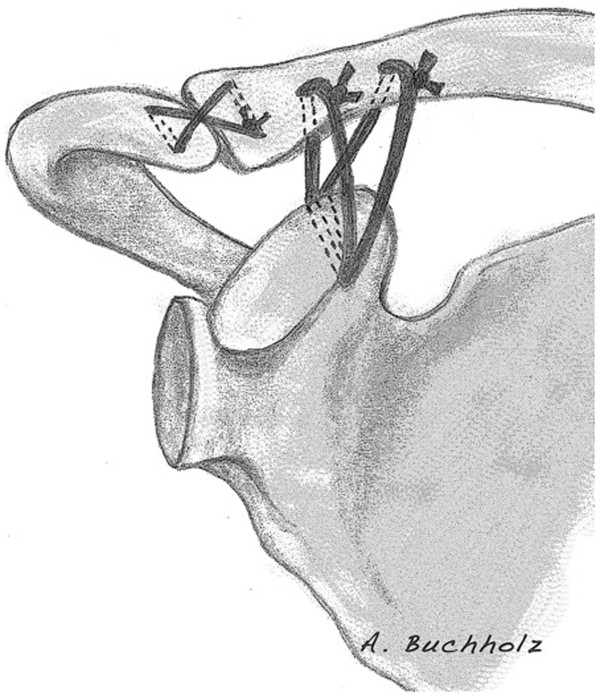
Scheme of the triple cerclage technique.